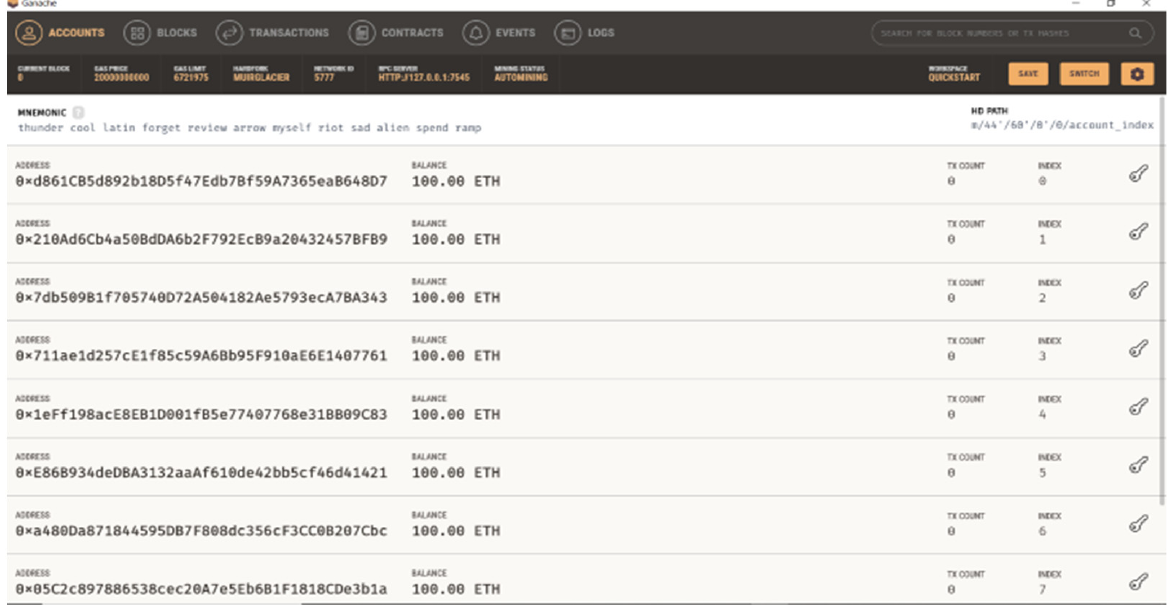
Figure 9. Ganache framework.